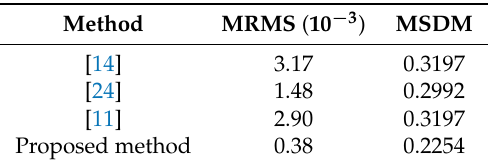
Table 13. Imperceptibility comparison with Cho’s [14], Rolland-Neviere’s [24] and Jeongho Son’s [11] schemes measured in terms of MRMS and MSDM for the Horse